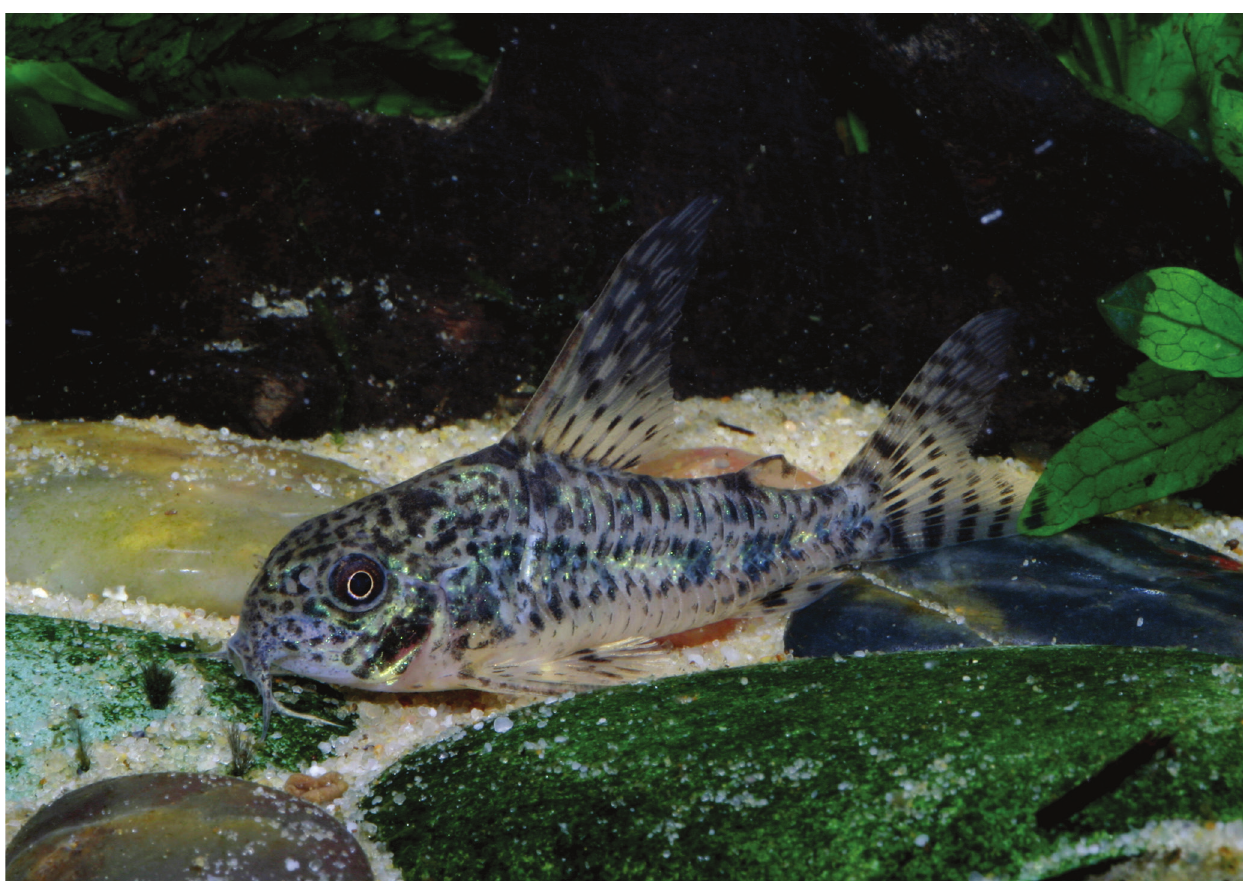
Fig. 5. Photograph showing an aquarium specimen of Corydoras sp. ‘Misiones’ with 35.0 mm SL. Photo by Ian